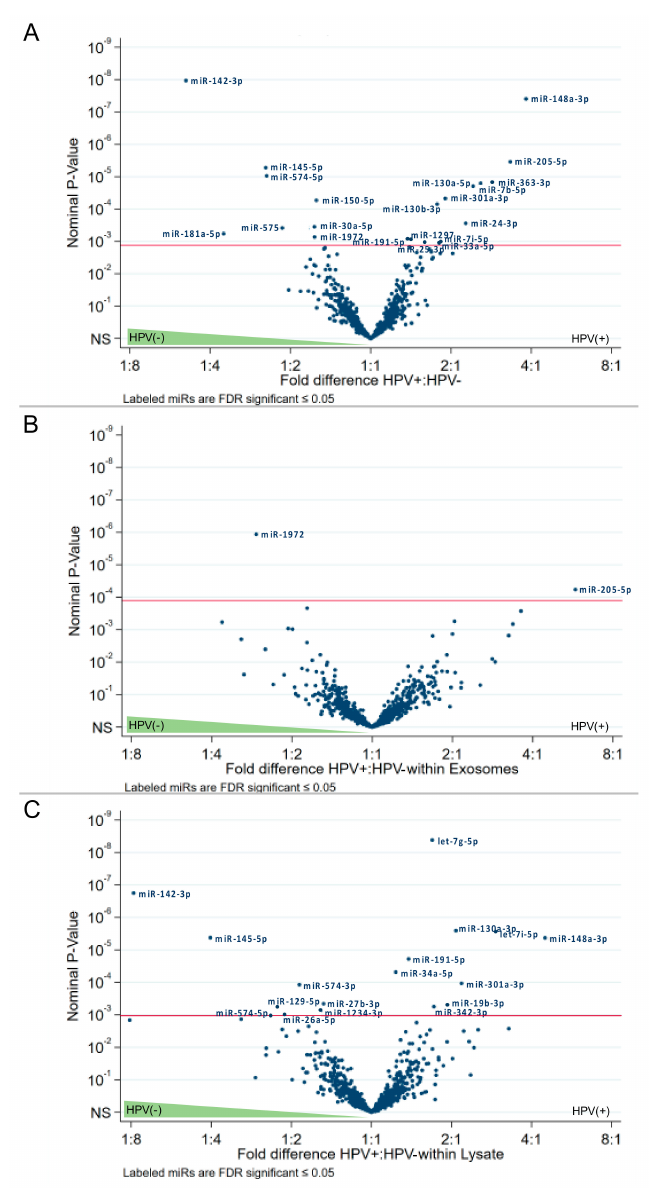
Figure 5. Volcano plot analysis of miRs depending on the HPV-status. Relative miR expression (blue dots) is analyzed for HPV( + ) vs. HPV( − ) cell lysates and exosomes ( A ), exosomes only ( B ) and lysates only ( C ). Dots at the right upper side are expressed to a higher extent in HPV( + ) than in HPV( − ), while dots at the left upper side are far more expressed in HPV( − ) than in HPV( + ). The vertical axis represents the significance level of the false discovery rate. p -values ≤ 0.05 are considered to be significant (red